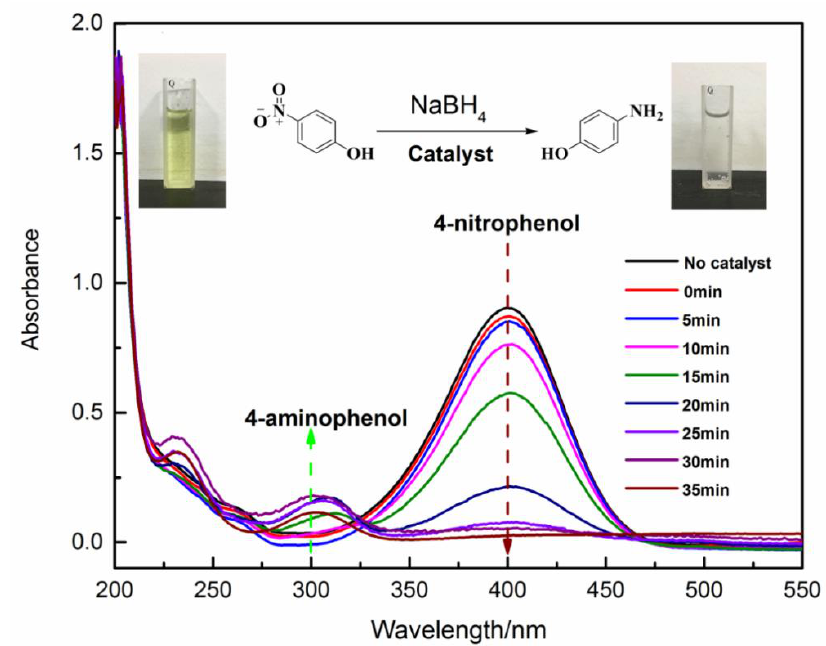
Figure 9. UV-Vis spectra of 4-nitrophenol reduction with Au / HSOSs as a catalyst. Insets are the reaction scheme, associated color change from bright yellow to colorless and the conversion of 4-nitrophenol graph in 35 min.